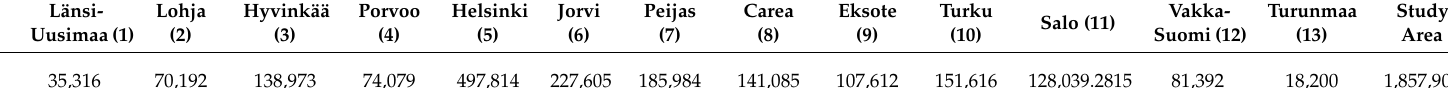
Table 2. Personnel full time equivalents (FTE) resources on mental health services per 1000